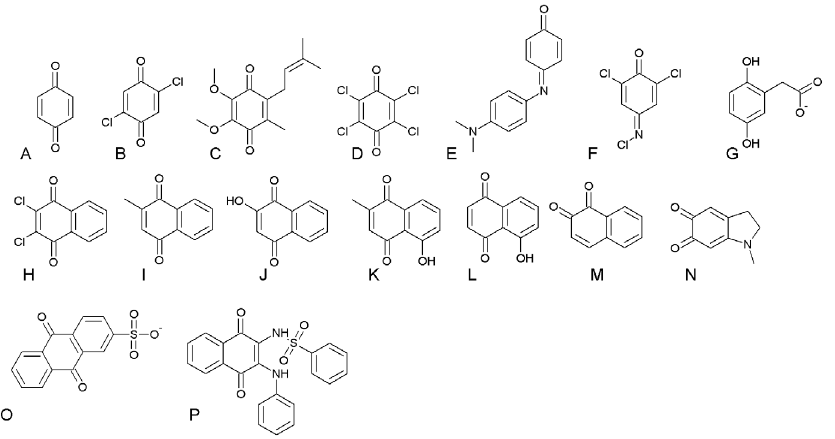
Figure 2. Structures of the quinone substrates tested in this manuscript. (A) Bzq, (B) Dcb, (C) UQ1, (D) Tco, (E) Phb, (F) Ibc, (G) Hom, (H) Dcn, (I) Men, (J) Law, (K) Plu, (L) Jug, (M) Onq, (N) Ade, (O) AQN, (P) Co7.